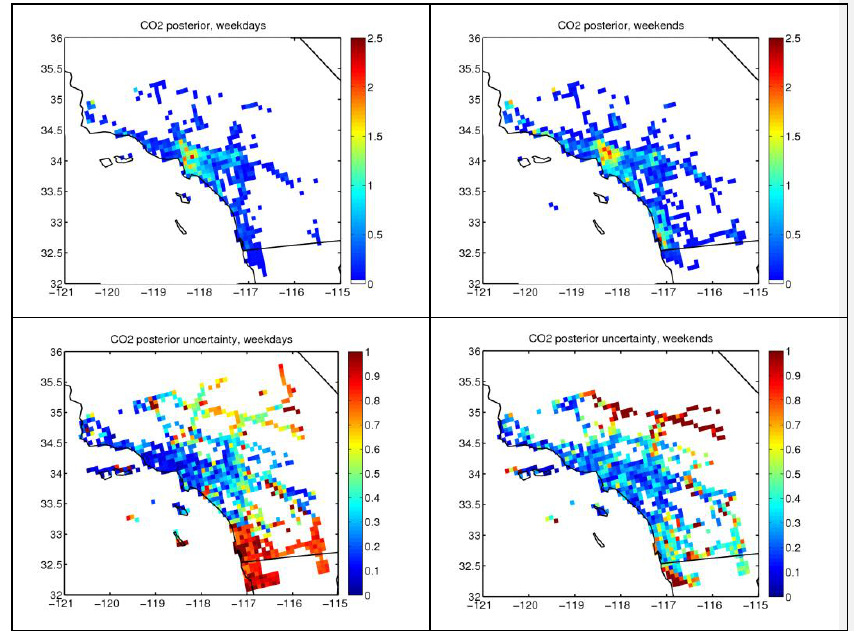
Fig. 5. Daytime average surface flux of CO 2 during weekdays (10 − 6 kgs − 1 m − 2 , top left) and weekends (top right); fractional uncertainties Figure 5 . Daytime average surface flux of CO2 during weekdays (10 -6 kg/s/m 2 , top left) and 5 in the posterior during weekdays (bottom left) and weekends (bottom weekends (top right); fractional uncertainties in the posterior during weekdays (bottom left) 6 and weekends (bottom right). 7